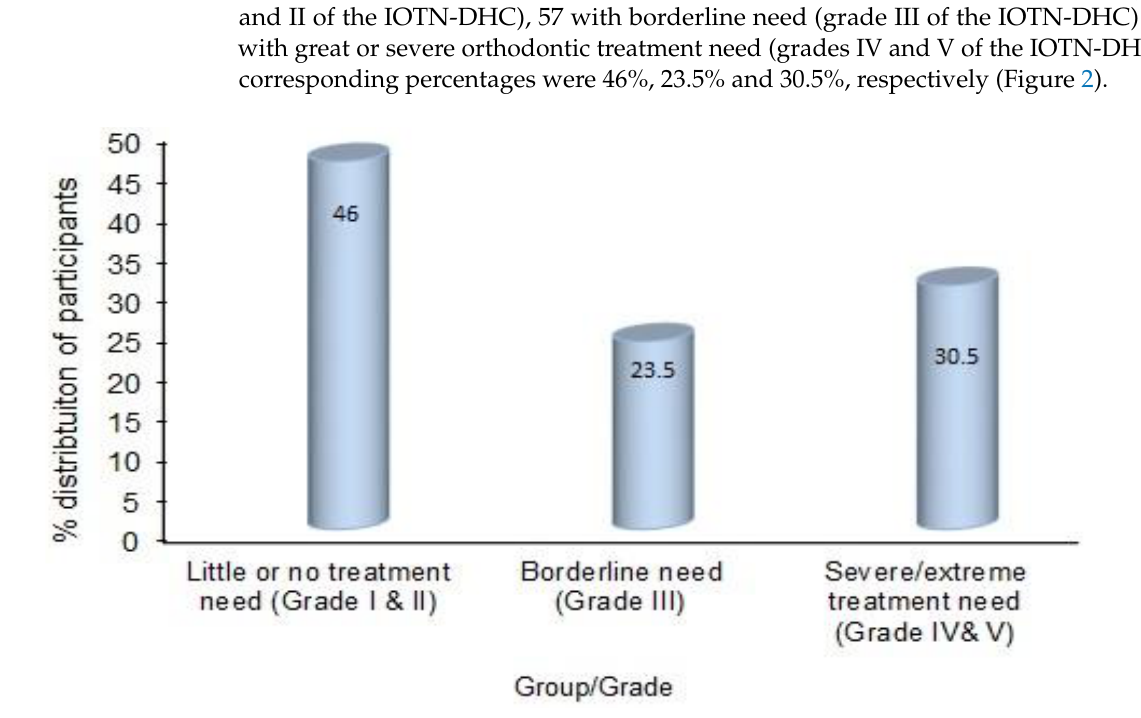
Figure 2. Distribution of the participants according to IOTN-DHC.